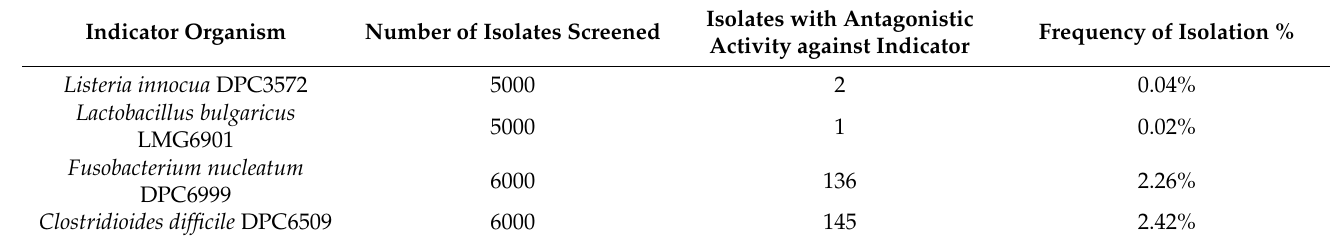
Table 2. Isolation frequency of intestinal gut isolates using different indicator organisms.